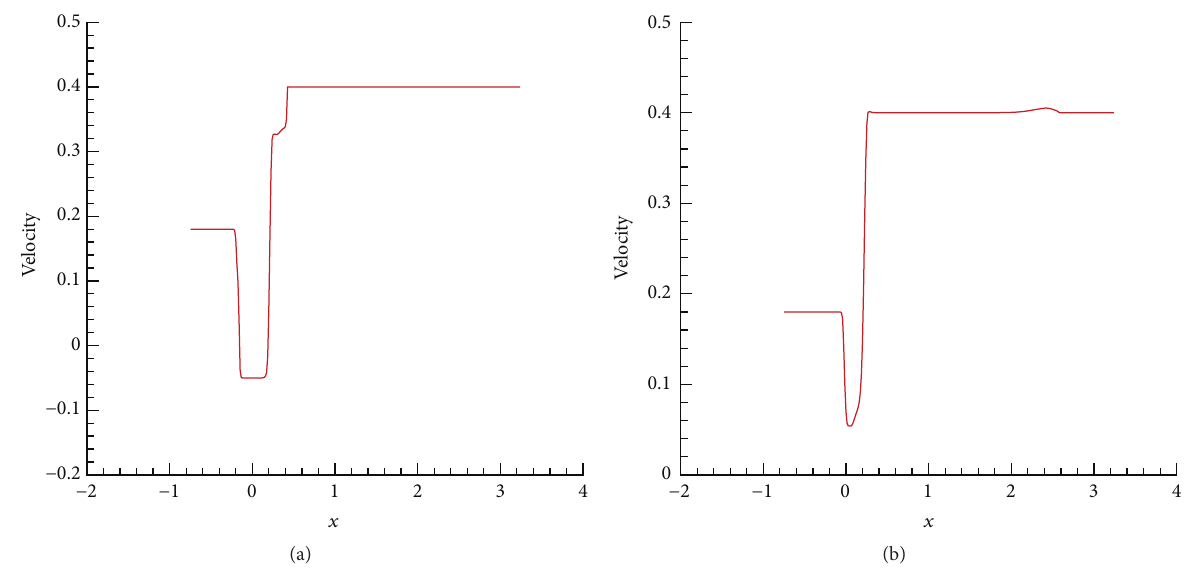
Figure 11: Numerical results of 𝑢 at 𝑡 = 0.5 (a) and 𝑡 = 5.5 (b) for Data 3.